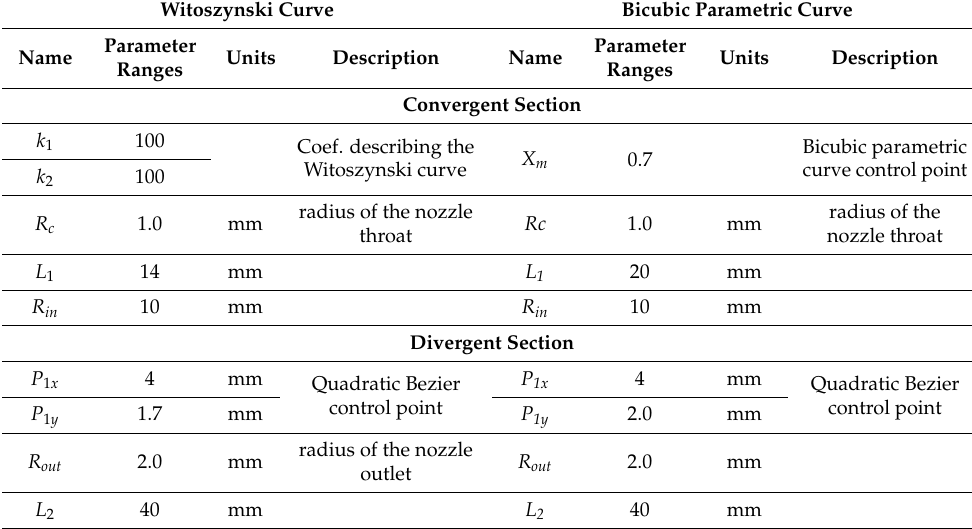
Table 3. Optimal nozzle geometry